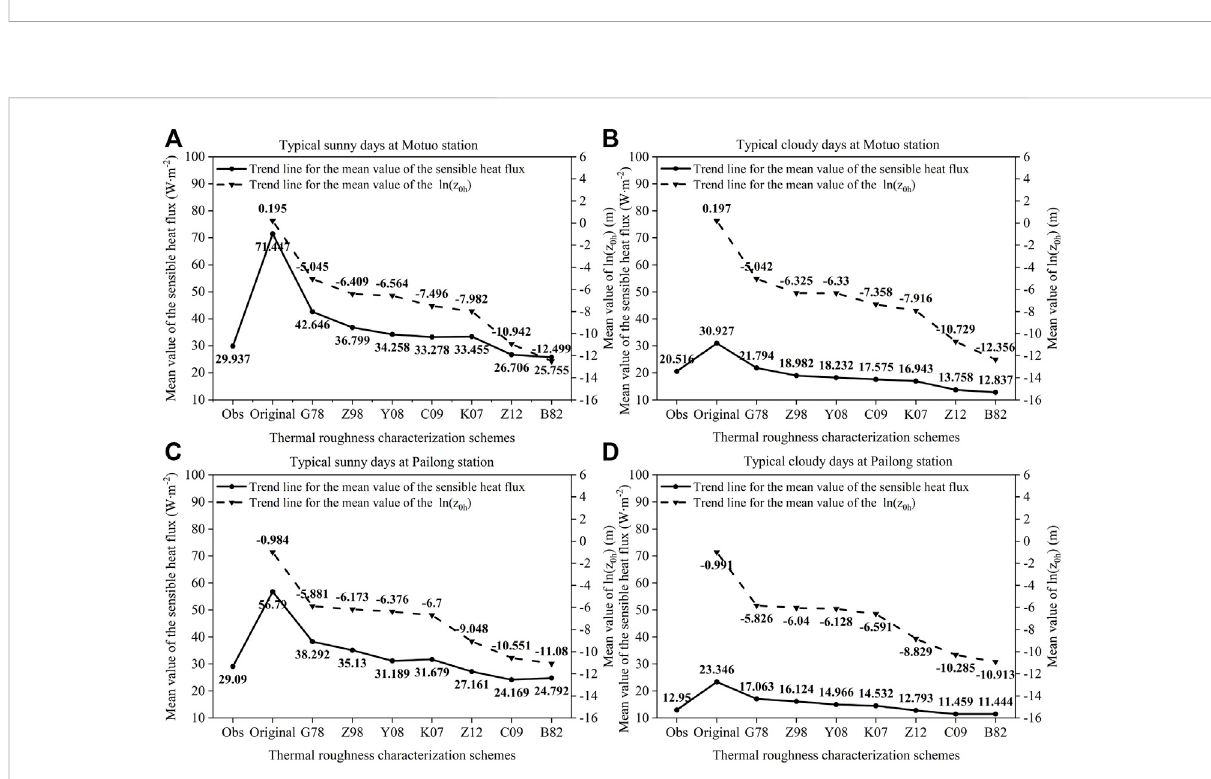
FIGURE 12 Comparison of the simulations of H and Z 0h under different Z 0h schemes on typical sunny/cloudy days at Motuo and Pailong